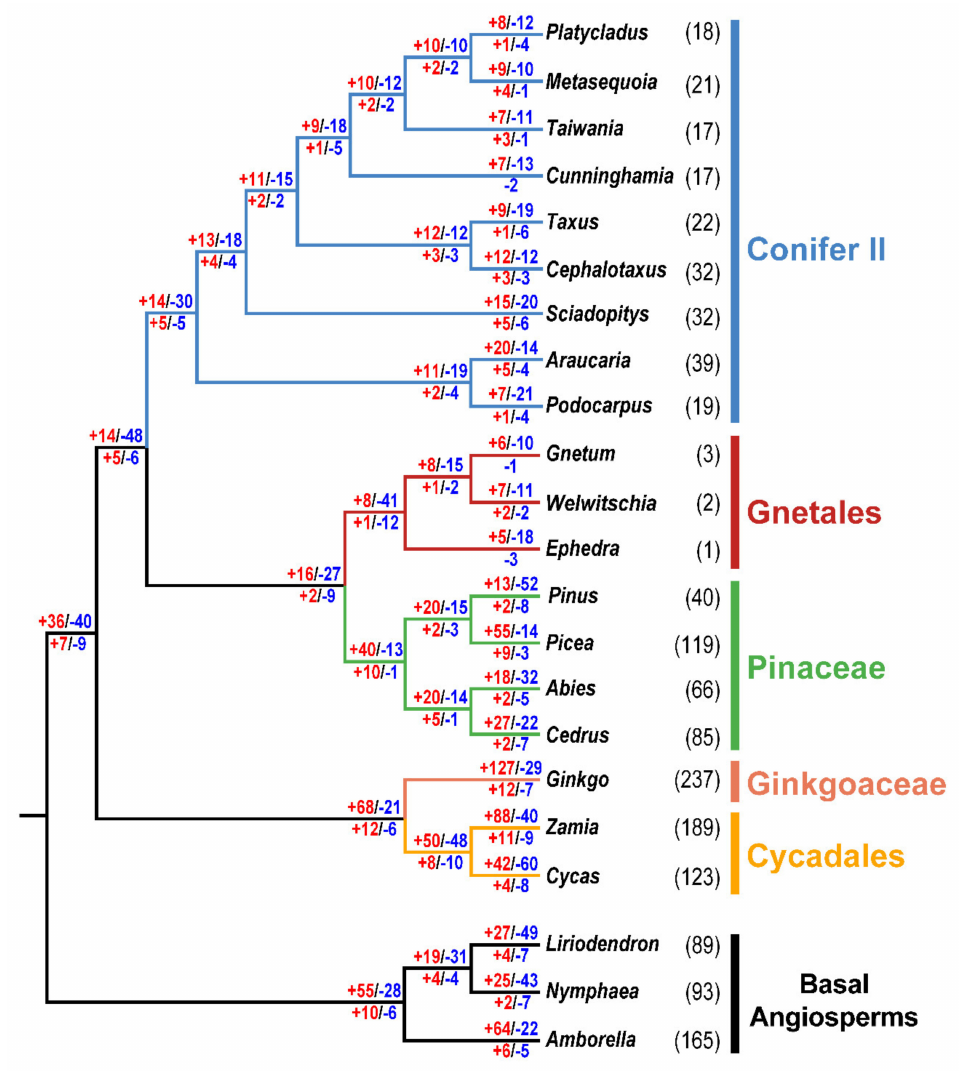
Figure 7. Ancestral state reconstruction of chloroplast C-to-U RNA editing sites during the evolution of gymnosperms. Numbers above the branches denote number of gain and loss events of C-to-U RNA editing sites in the CDS regions, and numbers below the branches are numbers of genes (14 genes containing C-to-U RNA editing sites in at least ten species in 19 gymnosperm species, details see Table S3) gained and lost C-to-U RNA editing sites, respectively. Values in parentheses are the number of C-to-U RNA editing sites detected in the CDS